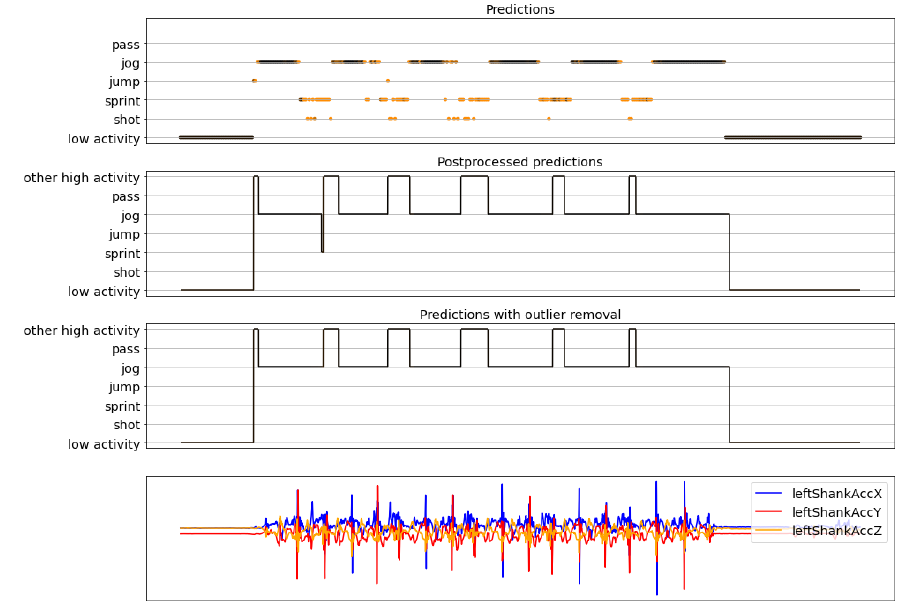
Figure 20. Example 2 of final results. True labels: jog and turn 5 times with a final